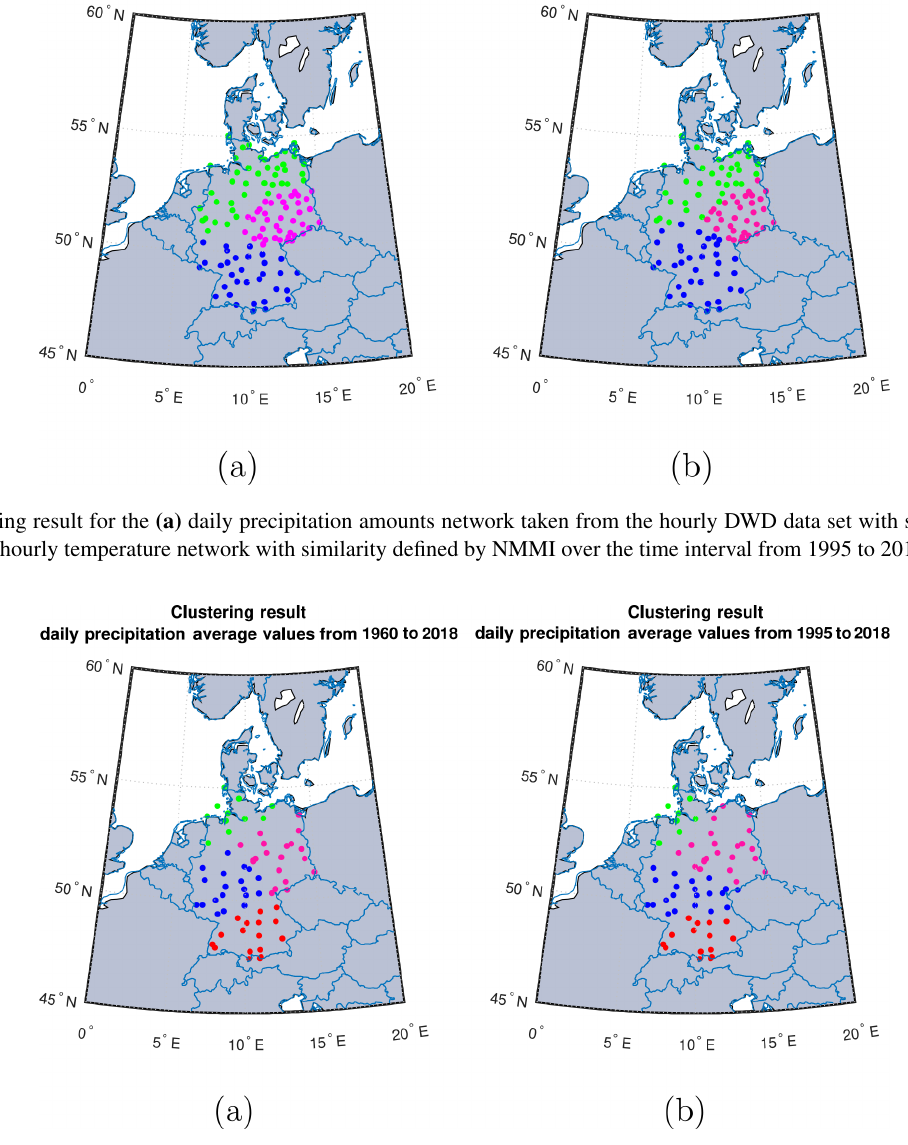
Figure 5. Clustering result for the daily precipitation amounts network taken from the daily DWD data set over (a) the time interval from 1960 to 2018 and (b) the time interval from 1995 to 2018 with similarity defined by